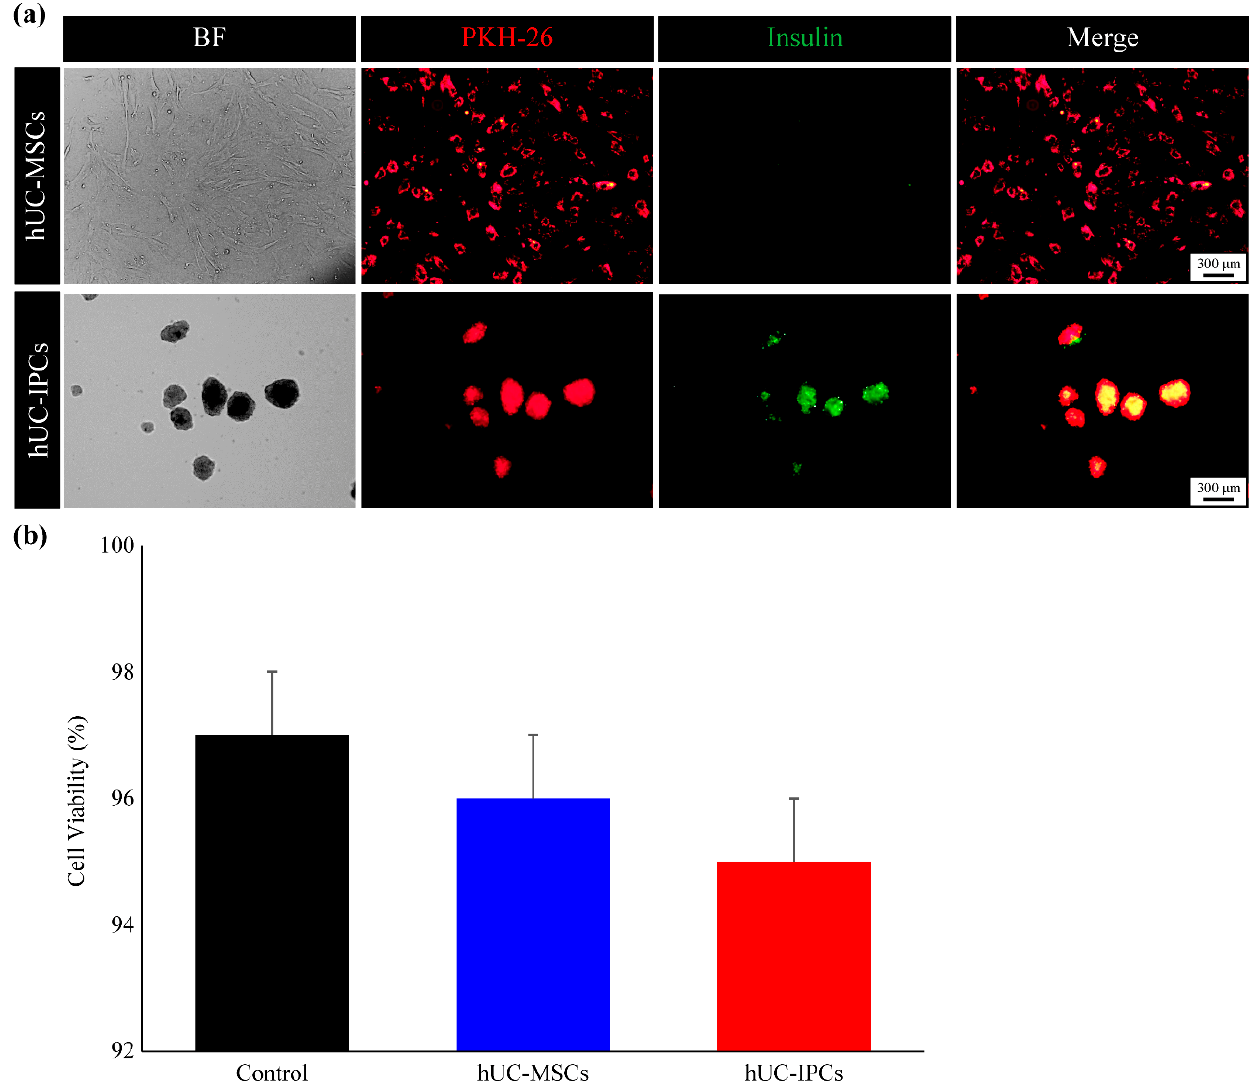
Figure 5. Identification of PKH-26-Red-stained hUC-MSC-derived trans-differentiated IPCs. ( a ) All fluorescent stained cells were observed under ×40 objectives, and representative images are shown. ( b ) Cell viability in controls, hUC-MSCs, and hUC-IPCs labeled with PKH26-Red determined using